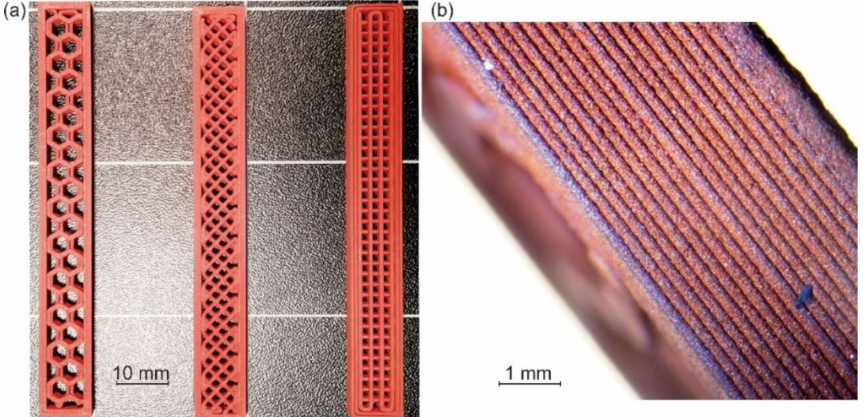
Figure 4. ( a ) Examples of bending specimens with three infill patterns at 50% infill degree (left to right: hexagonal, diagonal and linear 0/90) and ( b ) side view of a printed specimen showing the deposited